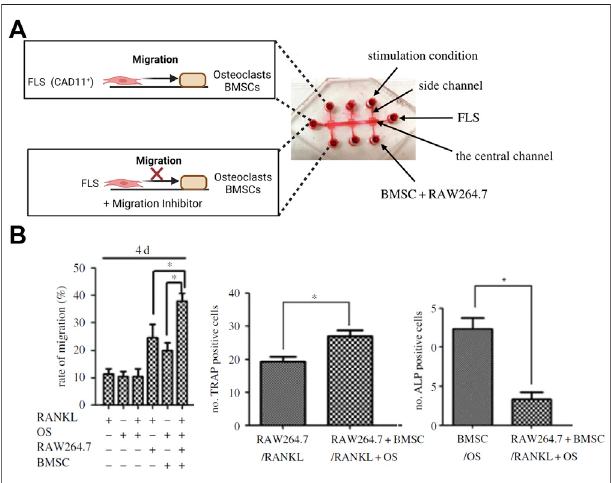
FIGURE 6 | Compartmentalized organs-on-a-chip feature migration dynamics of an arthritic tissue microenvironment. (A) Using a triple culture biochip,thebiochipmodelwasusedtoanalyzeFLSmigrationtowardsabone model (bottom panel) to simulate fi broblast invasion mechanisms in bone tissue. (B) The rate of synovial migration was highest for the triple coculture stimulated with Receptor Activator of NF- κ B Ligand (RANKL; left graph). An increase in numbers of TRAP-positive catabolic osteoclasts and decrease of anabolic ALP-positive osteoblasts recapitulates in vivo -like processes happening during the synovial bone invasion and bone erosion. Reproduced with permissions from (Ma et al., 2018).